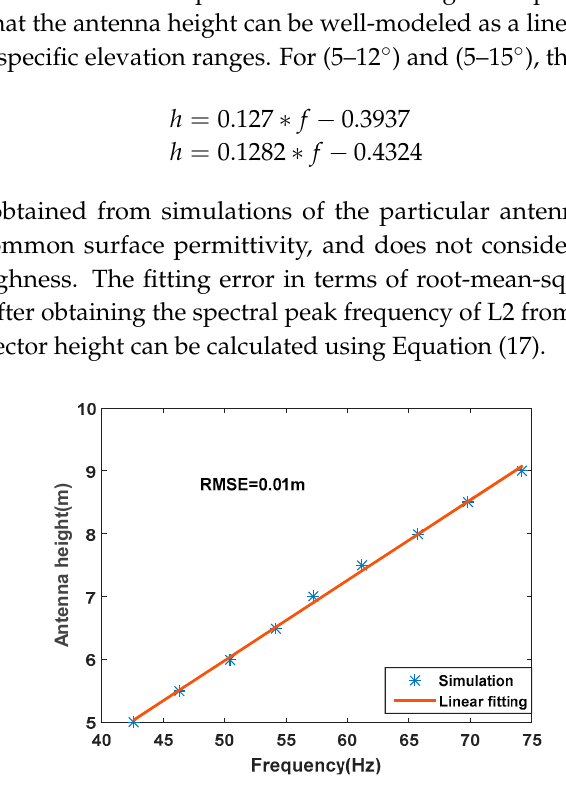
Figure 4. Graphical illustration of the linear relationship between peak frequencies and antenna height from the model for the elevation range 5–12°.